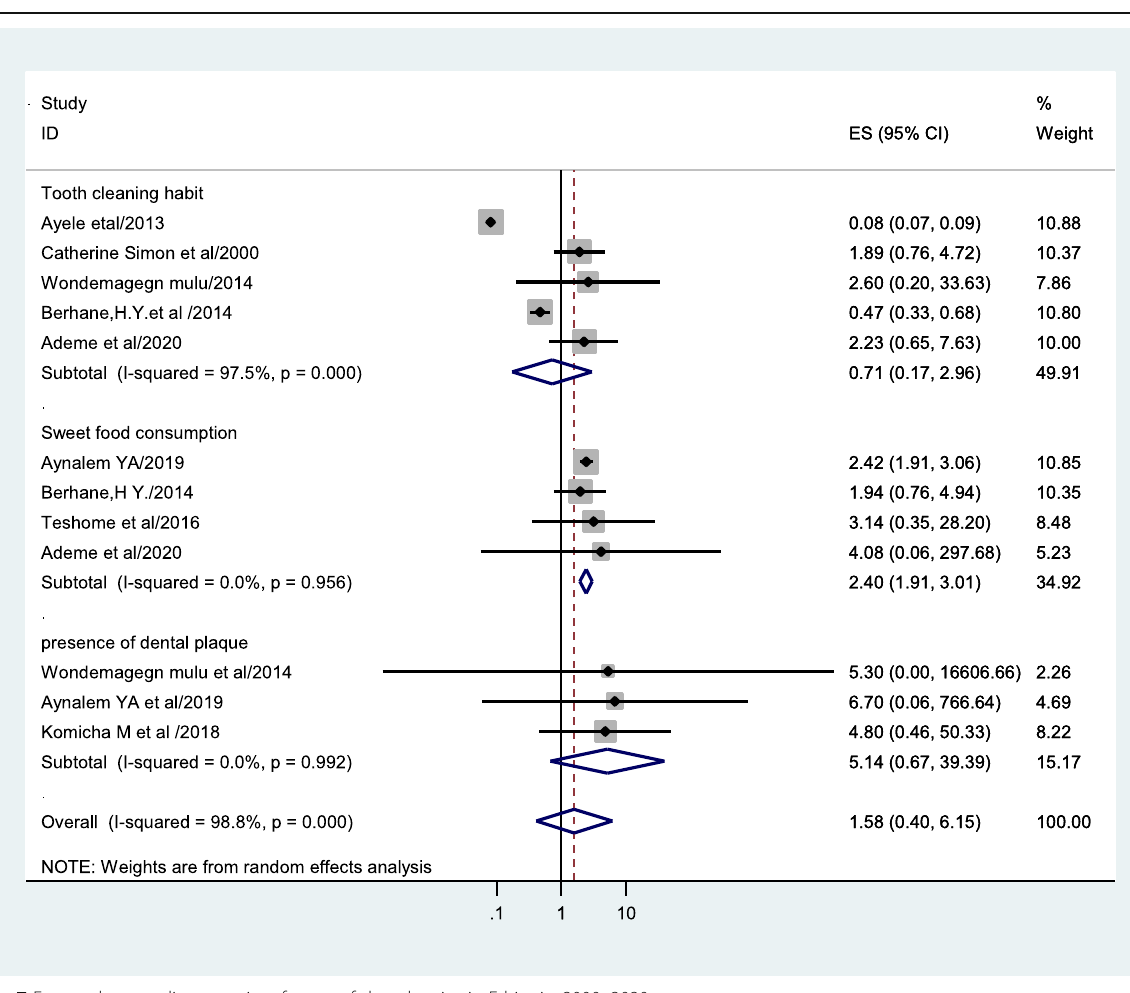
Fig. 7 Forest plot revealing associate factors of dental caries in Ethiopia, 2000 –